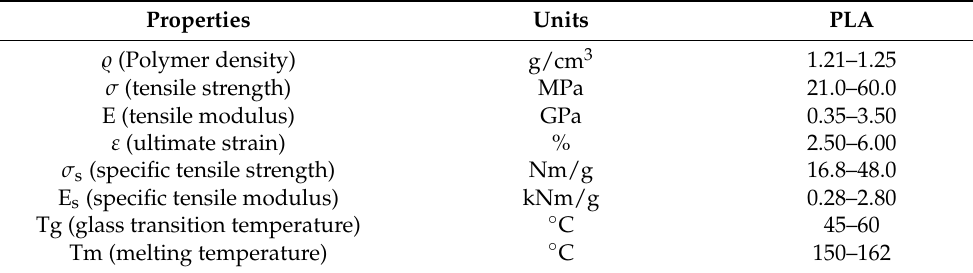
Table 3. Mechanical properties [65].